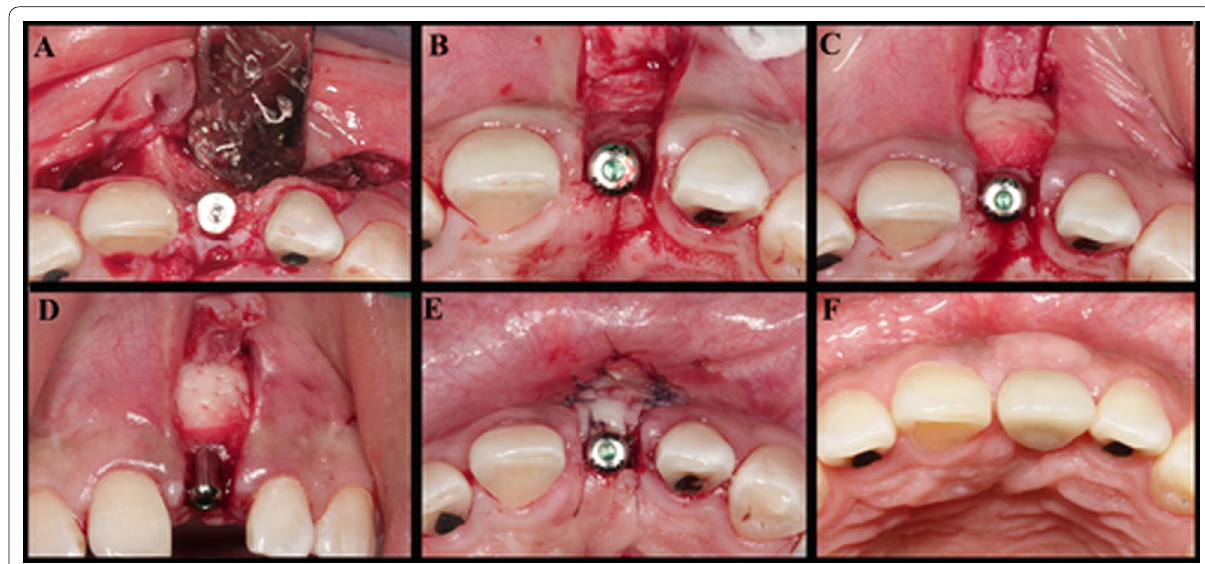
Fig. 7 Acellular dermal matrix used for soft tissue augmentation in a maxillary dental implant lacking buccal bone. ( A ) Clinical scenario before bone augmentation; ( B ) 6 months after guided bone regeneration; ( C and D ) soft tissue augmentation by using an acellular dermal matrix; ( E ) flap closure; ( F ) 5 year recall showing the stability of the obtained soft tissue volume. ( Adapted from ref. [88], copyright 2020, with permission from the